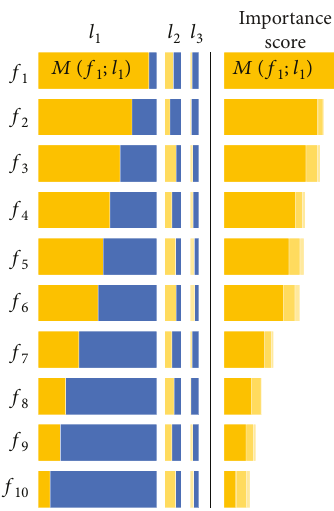
Figure 5: Importance score of each feature in the viewpoint of entropy of each label when entropy values of labels are skewed.